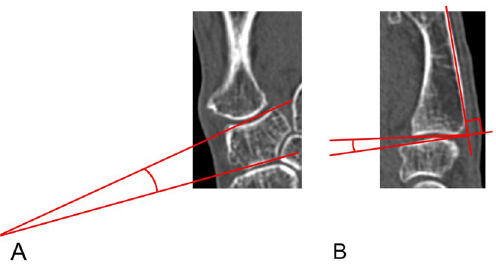
Figure 1. Computed tomography. ( A ) Trapezial inclination (TI) on the coronal view. ( B ) volar tilt (VT) on the sagittal view.